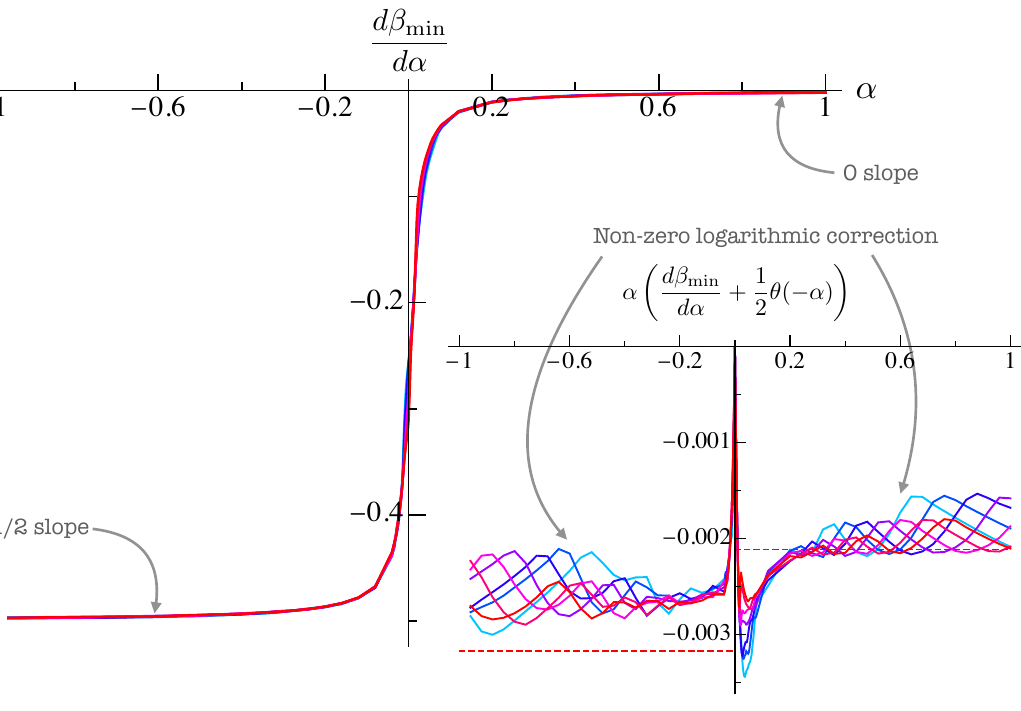
Figure 2 . Discrete derivative of β min ( α ) with respect to α for different values of N max (same colour coding as in figure 1). We see that for large negative (positive) α we approach the expected − 1 / 2 ( 0 ) slope from the naive bounds (1.4). This leading linear behavior is already seen clearly in figure 1. Interestingly, there are important logarithmic corrections to this as illustrated in the inset. There, we plotted the combination α ( dβ min /dα + 1 / 2 θ ( − α )) , involving the Heaviside θ -function. This combination kills the leading linear asymptotics and extracts the coefficient of any log at large | α | . Of course, numerical errors are magnified when we multiply by α which is why we get the numerical oscillations in the inset. Nevertheless, we see reasonable agreement with the analytic prediction (1.5) shown as red dashed horizontal